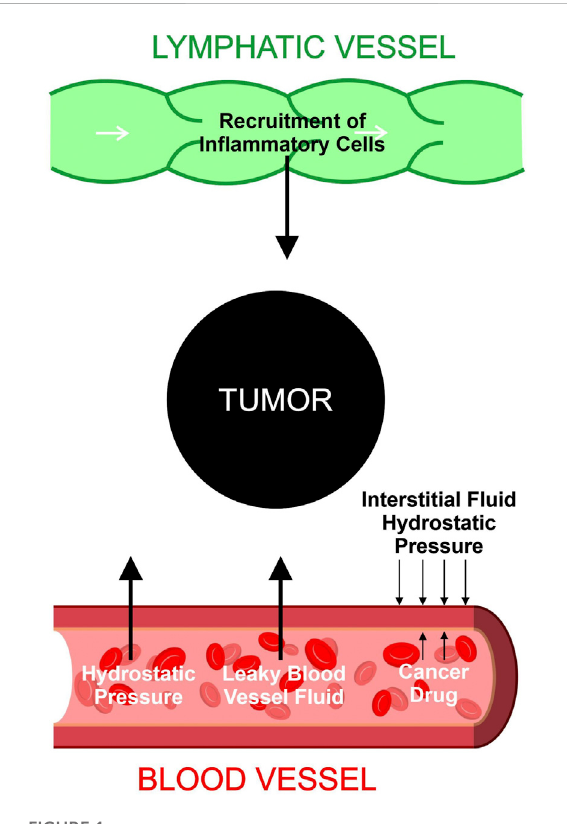
FIGURE 1 Contributions to tumor interstitial fl uid buildup. Hydrostatic pressure and leaky blood vessel fl uid increase the buildup of fl uid inside the tumor. Lymphatic vessels recruit in fl ammatory cells which accumulate in the tumor microenvironment and increasethetumorinterstitial fl uid.The hydrostaticpressureofthe interstitial fl uid provides an outward force that resists drug entry into tumor